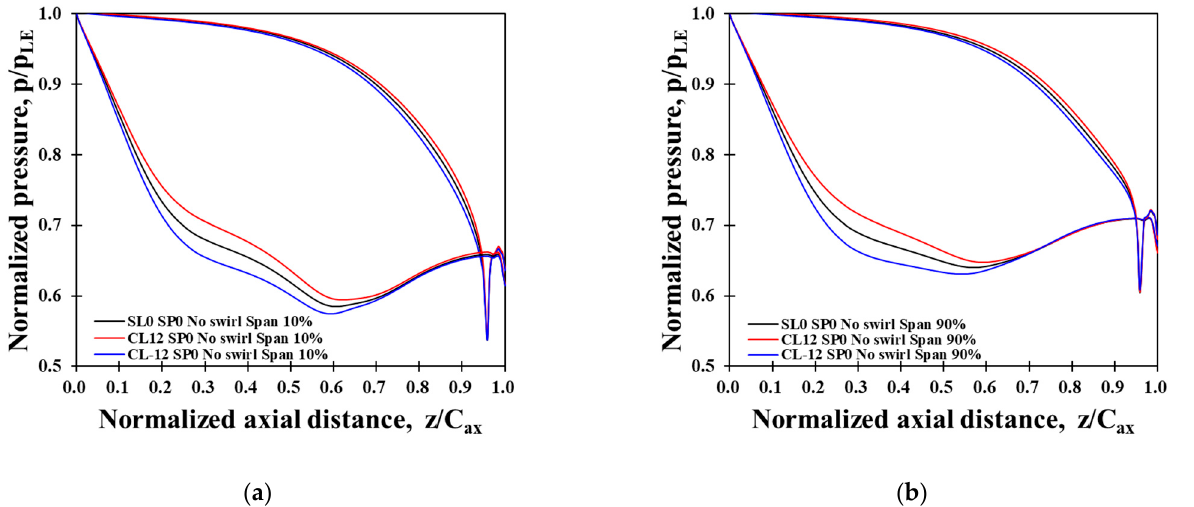
Energies 2021 , 14 , x FOR PEER REVIEW Figure 13. Comparison of NGV loading due to the straight lean angle: ( a ) Span height 10%; ( b ) Span height 90%.